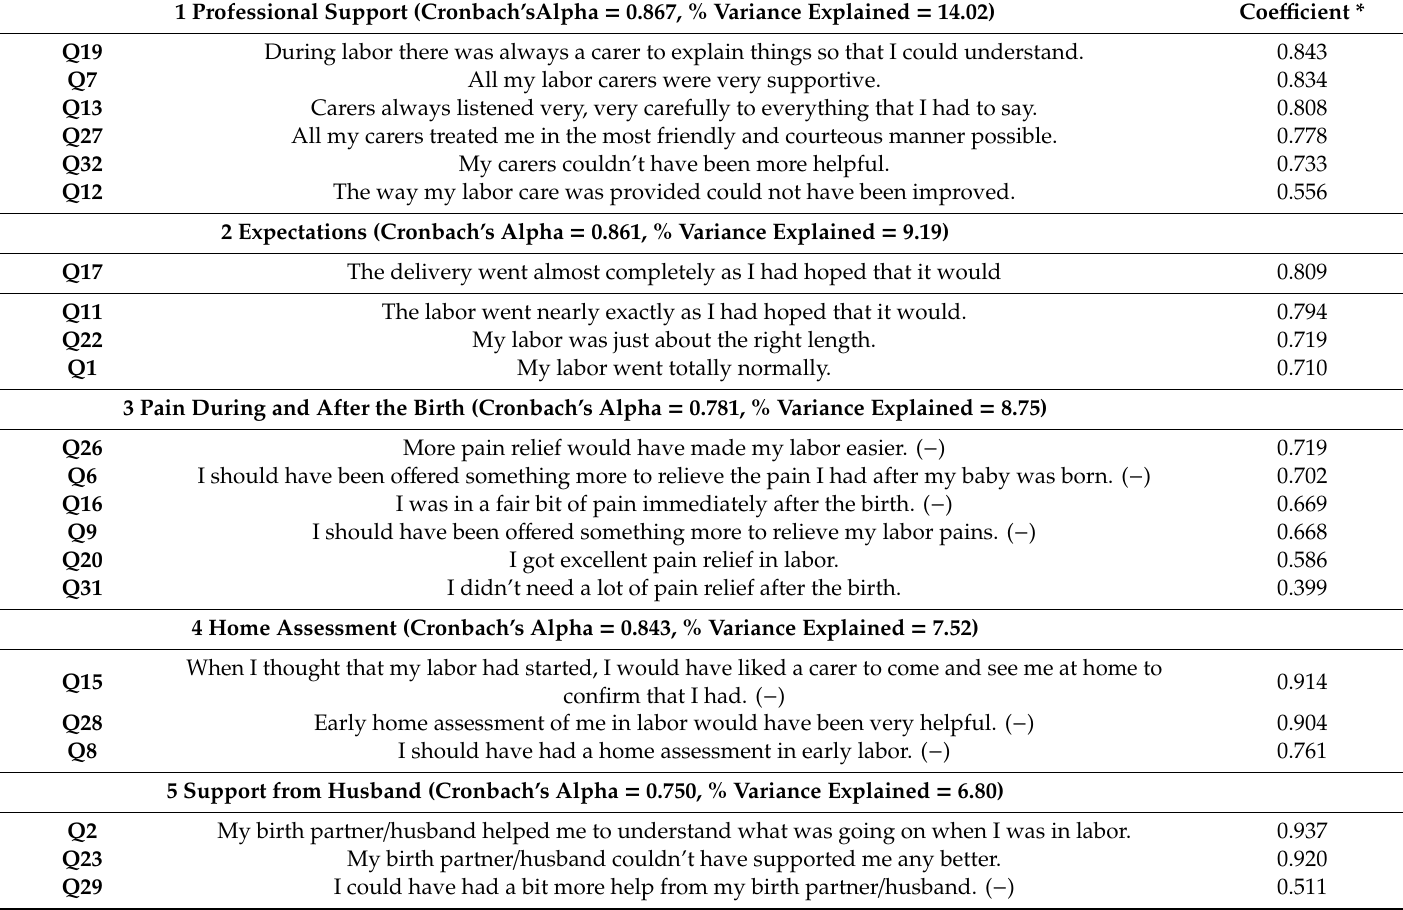
Table 2. Analysis of each dimension and items on the